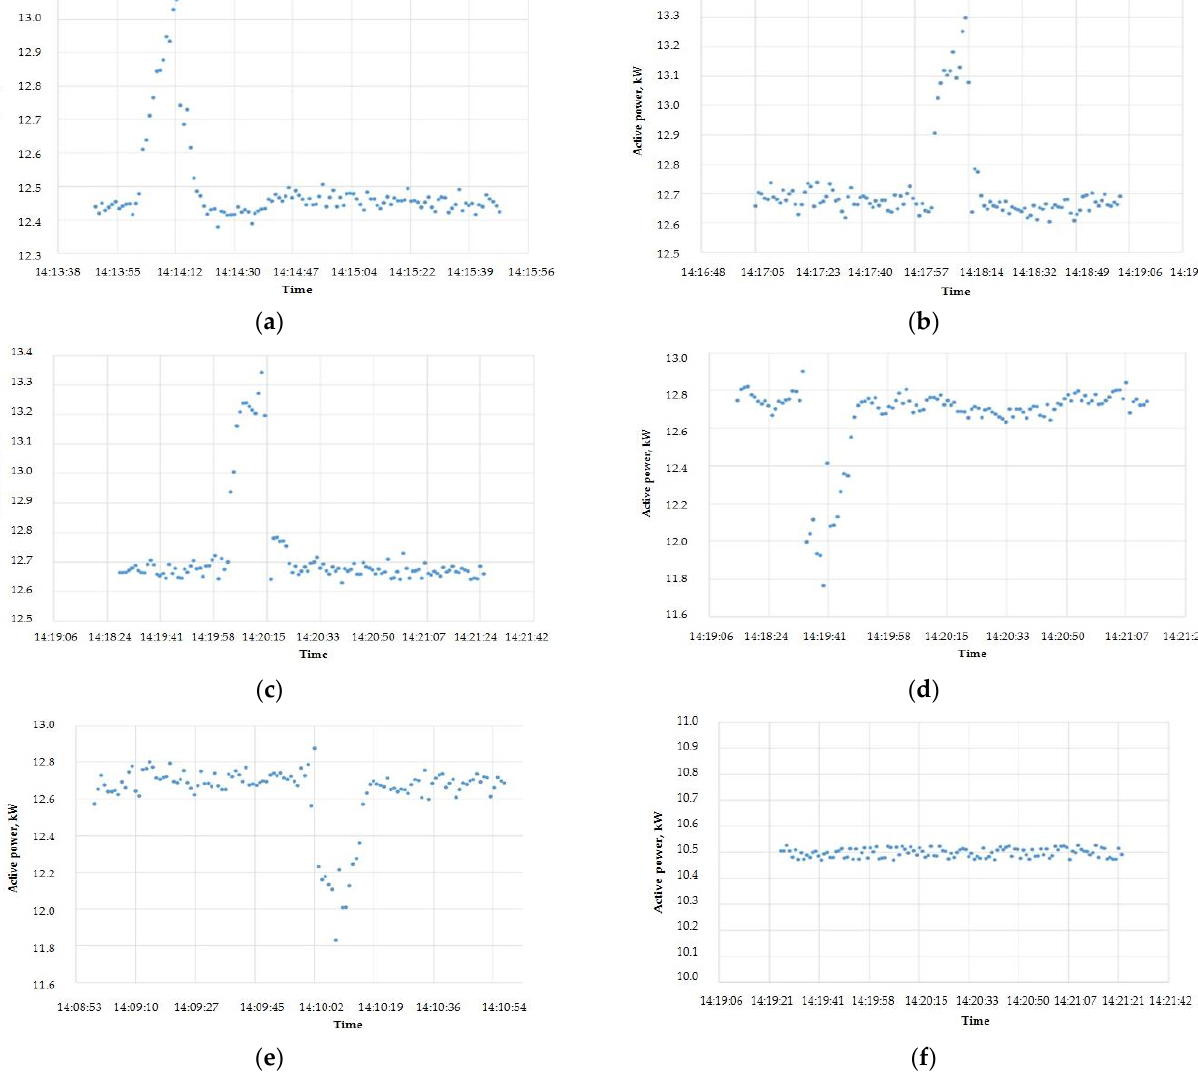
Figure 2. The active power curves of ( a ) exhaust fan 1 of DT2532 dryer; ( b ) exhaust fan 2 of DT2532 dryer; ( c ) exhaust fan 3 of DT2532; ( d ) recirculation fan 1 of dryer DT2532; ( e ) recirculation fan 2 of dryer DT2532; ( f ) coal stove fan of dryer DT2532.